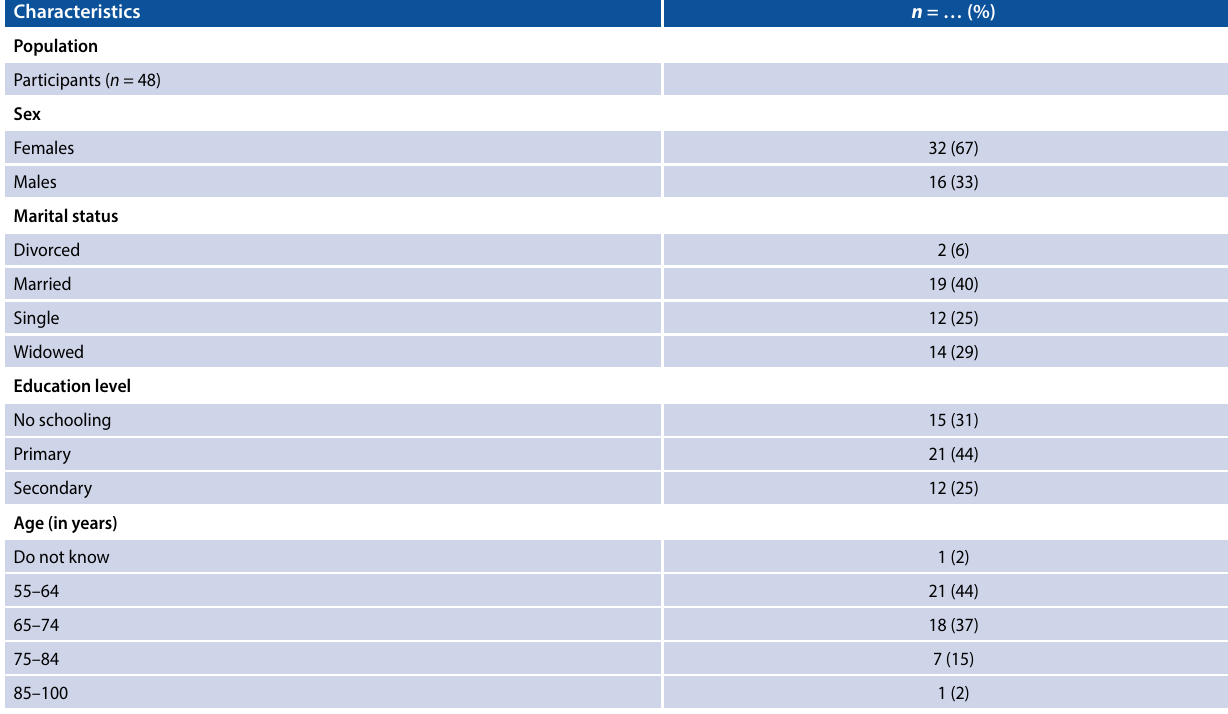
Table 1: Demographics of the participants Characteristics